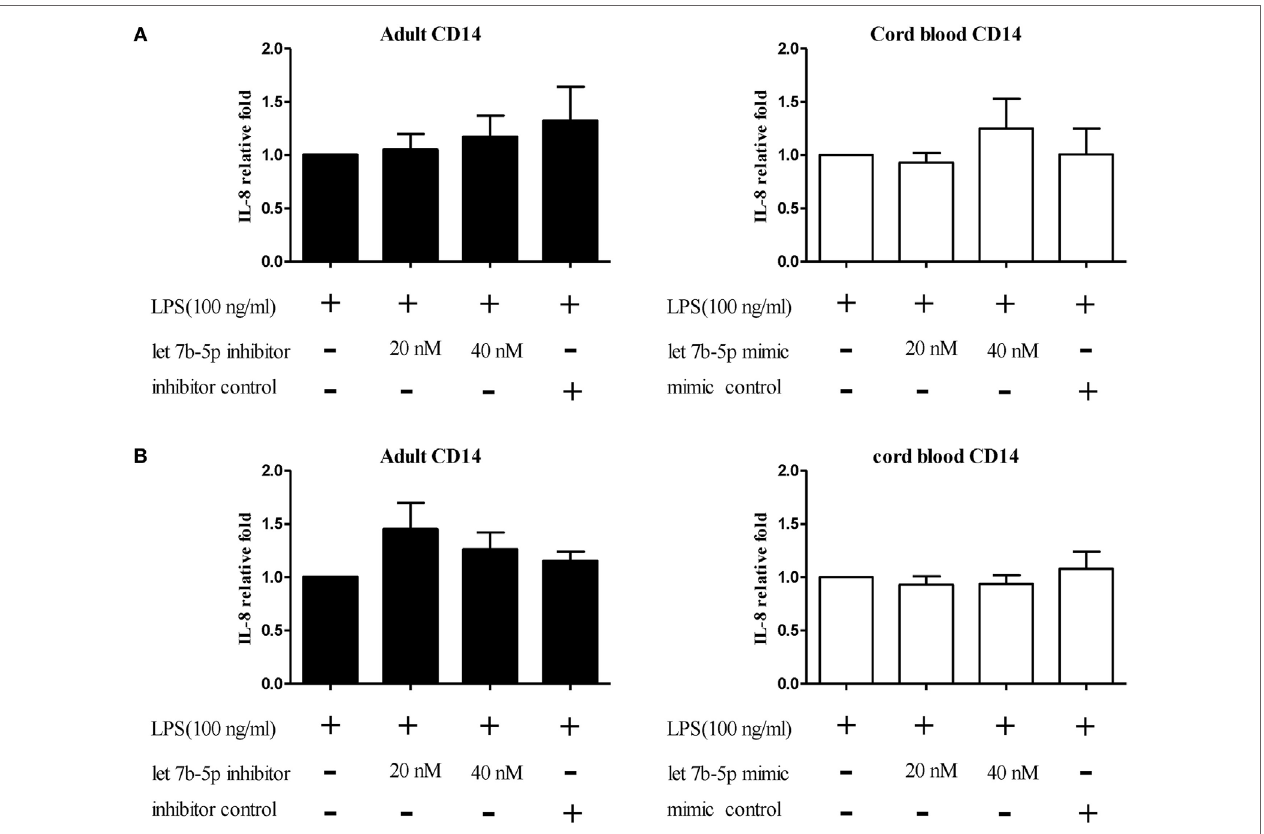
FigUre 15 | The effect of let-7b-5p on interleukin (il)-8 production by monocytes . Adult monocytes with or without let-7b-5p inhibitor transfection and cord blood monocytes with or without let-7b-5p mimic transfection were subjected to detection of the IL-8 protein after LPS stimulation for 16 h. The transfection times were (a) 24 h and (B) 48 h. IL-8 production is represented as relative fold expression compared to the LPS stimulation control. * p < 0.05 as compared with LPS stimulation only with Mann–Whitney U test ( n =